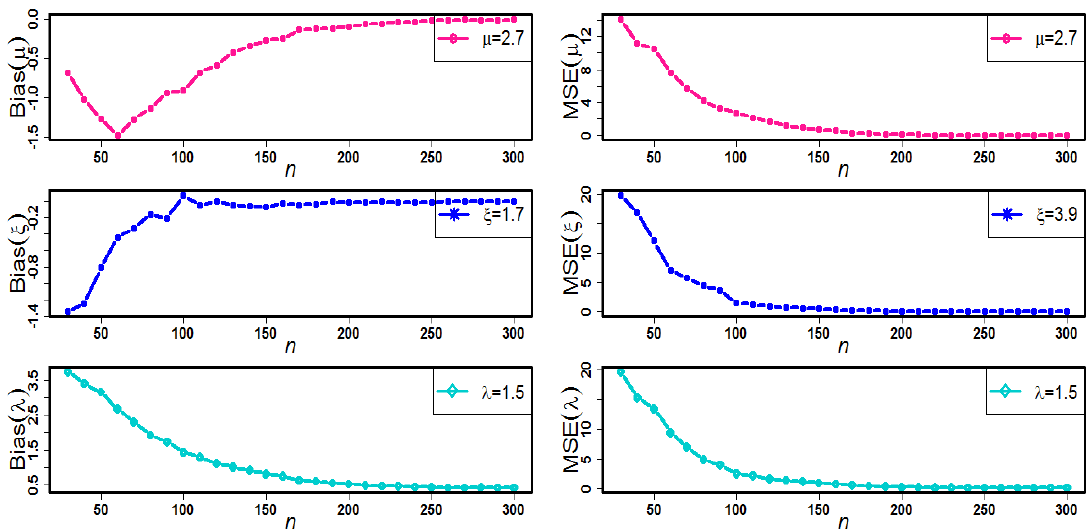
Figure 4. The performance of Bias and MSE profiles against ˇ µ , ˇ ξ and ˇ λ for